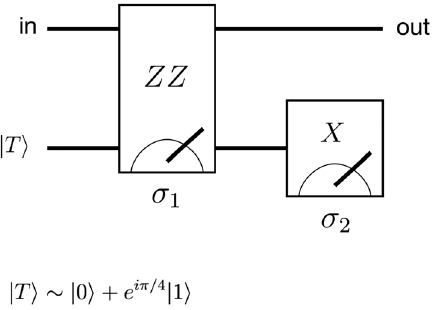
FIG. 4. Implementation of the T